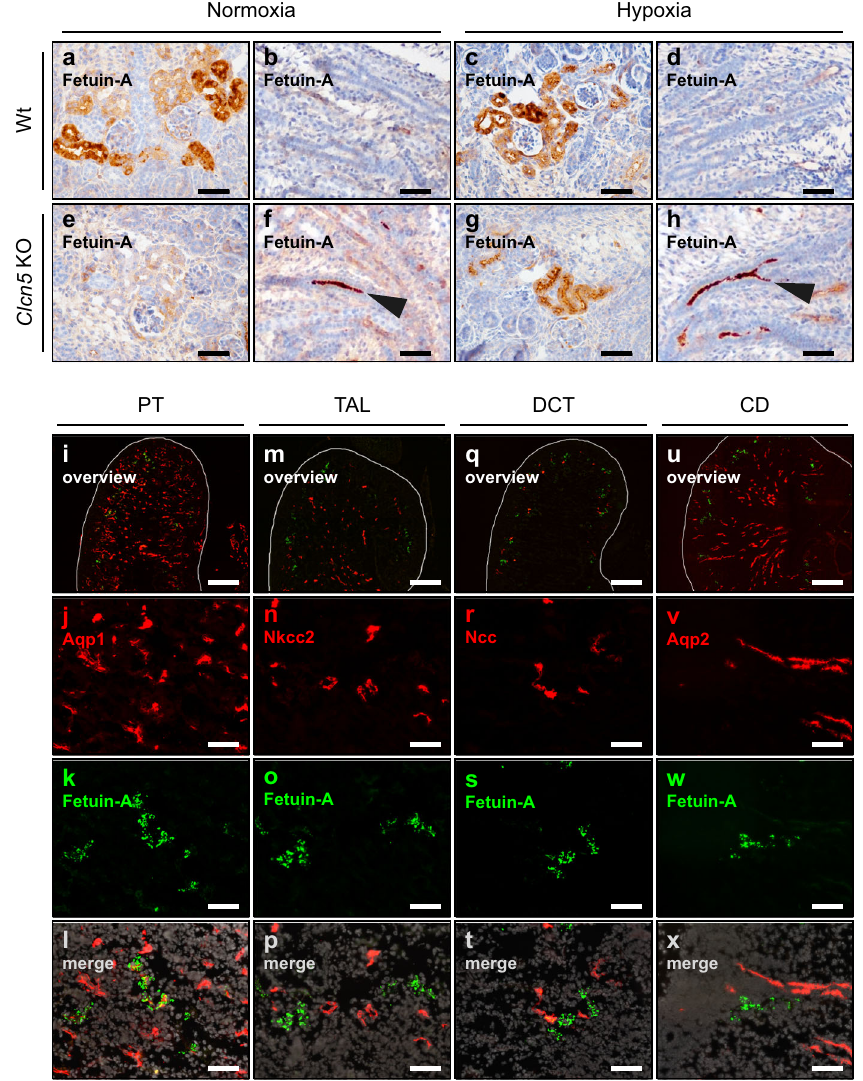
Fig. 3 Fetal hypoxia induces fetuin-A expression in the proximal tubulus. a – h Fetuin-A staining on E18.5 kidney sections of normoxic ( a , b , e , f ) or hypoxic ( c , d , g , h ), wild type ( a – d ) or Clcn5 KO ( e – h ) fetuses. Arrowheads indicate intraluminal fetuin-A staining that results from the impaired endocytosis of low molecular weight proteins in the PT of Clcn5 KO mice ( f , h ). i – x Immuno fl uorescence staining of the indicated nephron segment marker proteins (red) and fetuin-A (green) on E18.5 kidney sections. PT, proximal tubulus ( i – l ); TAL, thick ascending limb ( m – p ); DCT, distal convoluted tubulus ( q – t ); CD, collecting duct ( u – x ). Images are representative of at least three independent antibody stainings ( a – x ). Scale bar = 50 µ m ( a – x ), except overview images for which the scale bar = 300 µ